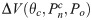
Effect of echo chamber.The graph shows the effect of the presence of the echo chamber for the network polarization level with highest effect, as a function of opinion polarization (i.e. ΔV(θc,Pnc,Po) as a function of Po). In other words, looking at Fig 3, for each level of opinion polarization, it substracts the virality without an echo chamber from peak virality, V(θc,Pnc,Po)-V(θc,0,Po). The dashed line represents the control case where the opinion polarization has been randomly assigned. As can be seen, the presence of an opinion polarized echo chamber has more impact than the presence of one that is not opinion polarized. In the control case, there is little positive interaction between network and opinion polarization. The lower graph shows the same curve for different network sizes, to show that the results are robust for varying network sizes. As can be seen, the effects of having a cluster present actually increases with the network size. Lower graph runs were averaged over 300 iterations, with average degree 8, and 20% of nodes were assigned to be part of echo chamber.